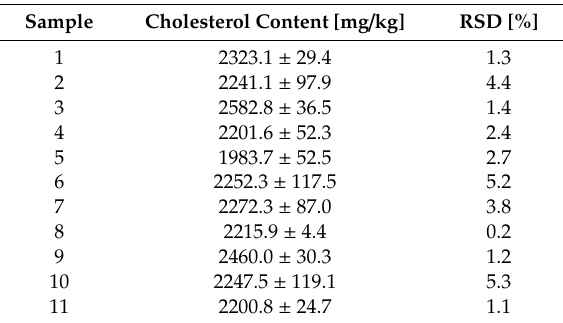
Table 3. Cholesterol content of butter samples.